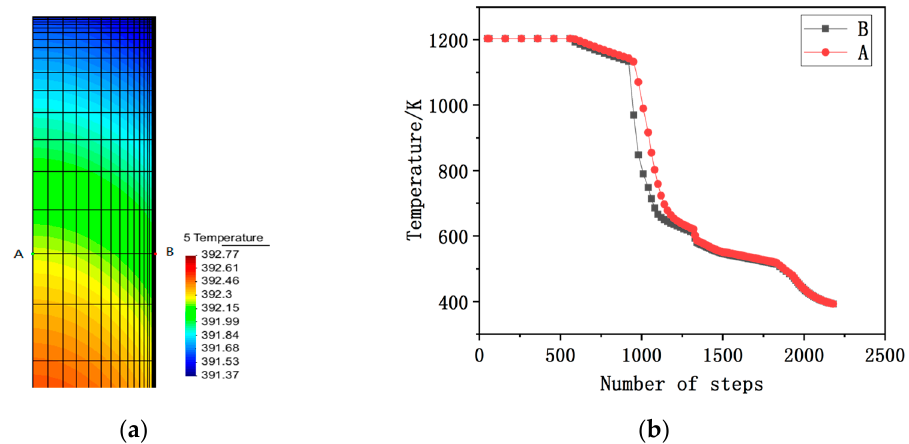
Figure 10. Inner and outer surface temperature change. ( a ) Location of point B and point A; ( b ) Temperature change.